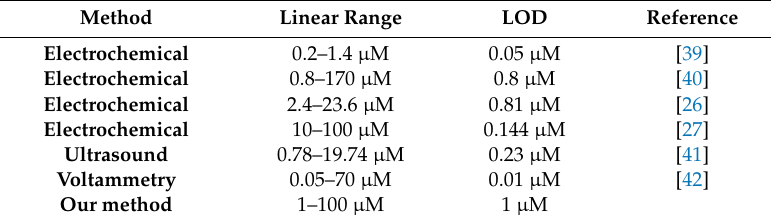
Figure 6. Fluorescence spectra of GQDs@SMIP ( A ) and GQDs@SNIP ( B ) in the presence of different concentrations of SMZ. The concentration of GQDs@SMIP and GQDs@SNIP is 5 mg/mL. Inset: calibration curve for the relationship between I / I 0 and the concentration of SMZ. Table 1. Comparison of SMZ detection for different methods.